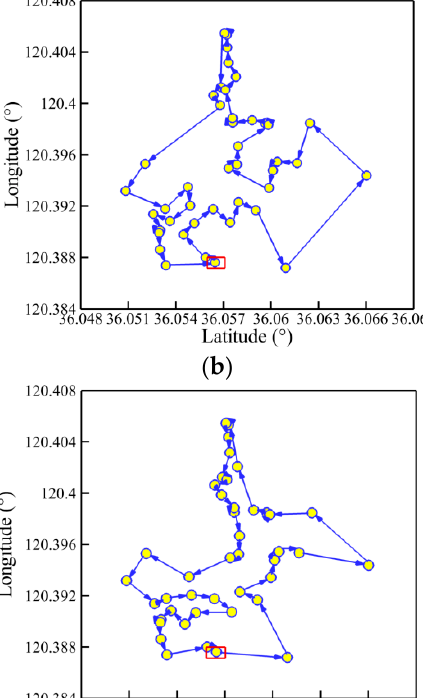
Figure 17. Trajectory planned by each algorithm for P = 35: ( a ) CGA; ( b ) SDIGA; ( c ) DDIGA; ( d ) MDIGA.